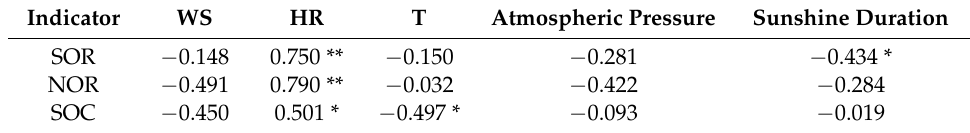
Table 5. Pearson correlation analysis of NOR, SOR, and meteorological elements and precursors. Indicator WS HR T Atmospheric Pressure Sunshine Duration